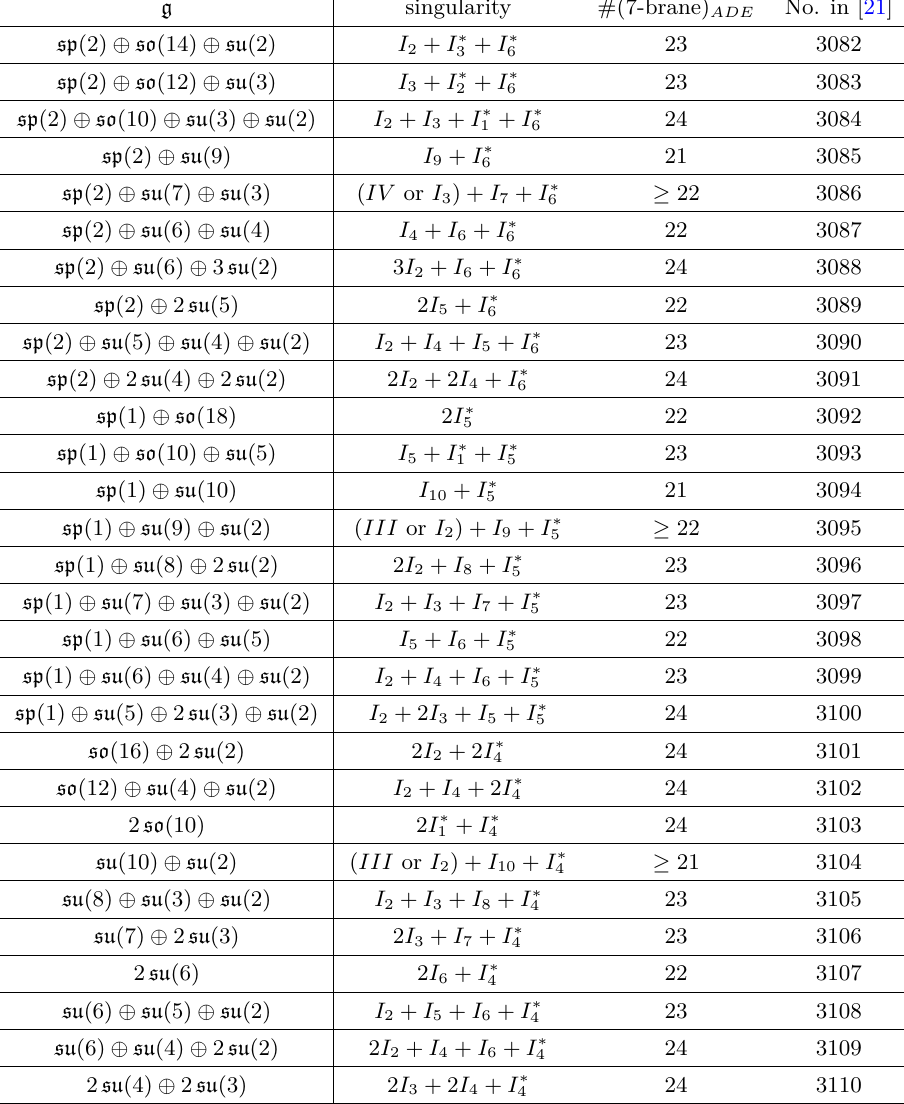
Table 5 . List of Rank = 10 theories realized in string theory (Part 2 / 2